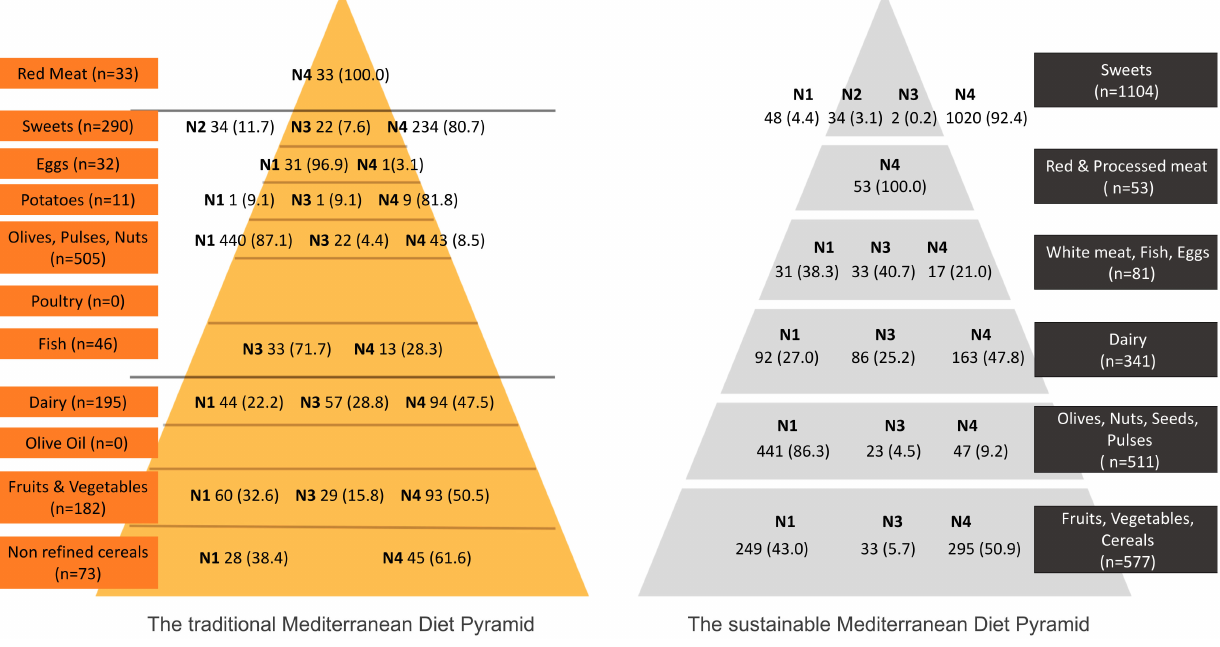
Figure 1. Distribution of the NOVA groups within the traditional and the sustainable Mediterranean diet pyramids’ food tiers. N1 = NOVA1, N2 = NOVA2, N3 = NOVA3, and N4 =